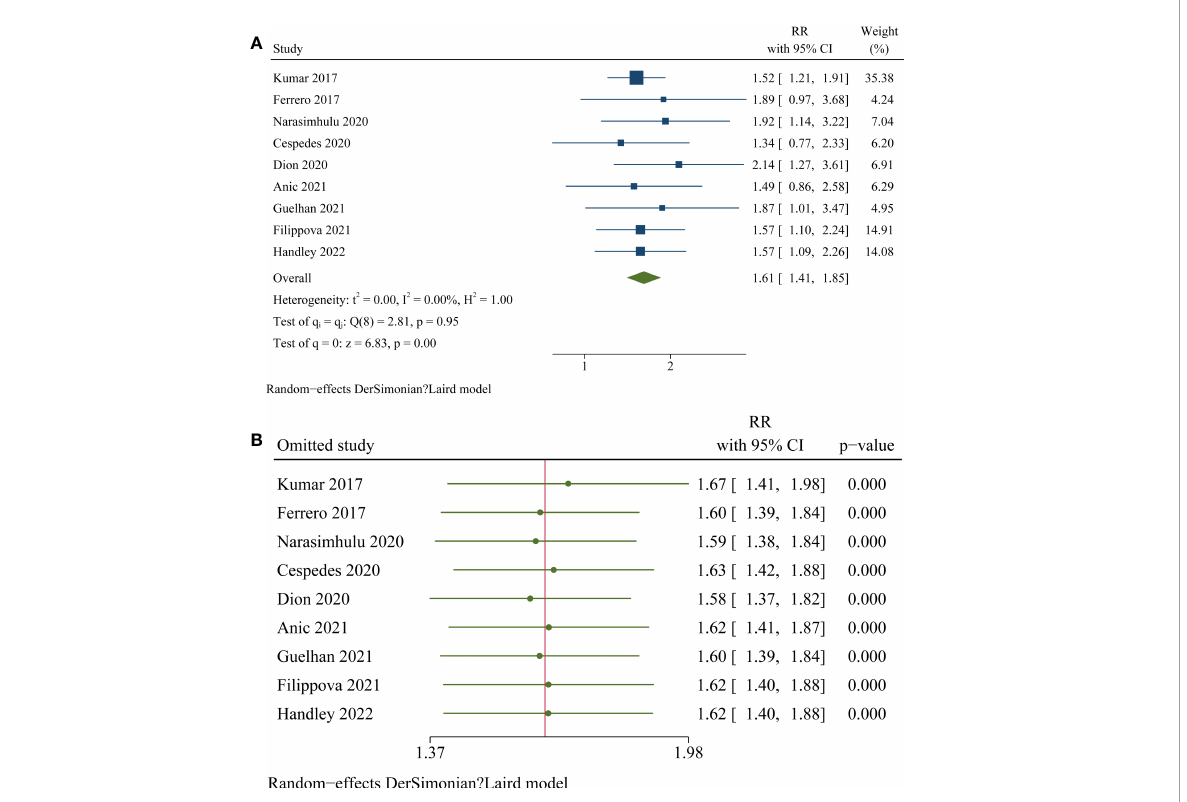
FIGURE 2 Forest plots for the meta-analyses regarding the association between high frailty and OS in patients with OC. (A) , overall meta-analysis; (B) , in fl uencing analysis by omitting one study at a